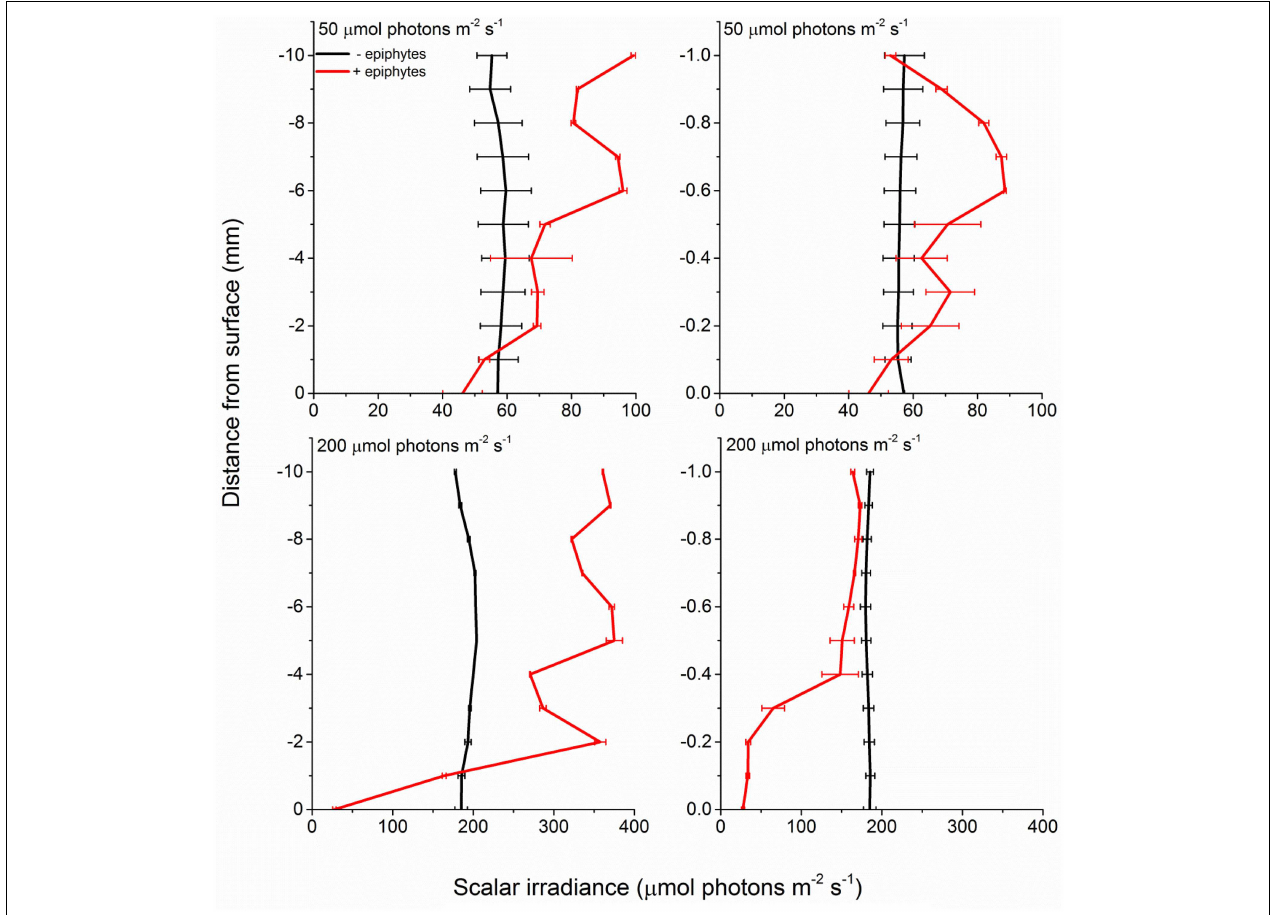
FIGURE 2 | Profiles of photon scalar irradiance measured at two different downwelling photon irradiances (50- and 200 µ mol photons m − 2 s − 1 ) on Z. marina leaves with- and without epiphyte cover. Left panels show the scalar irradiance 0–10mm from the leaf surface measured